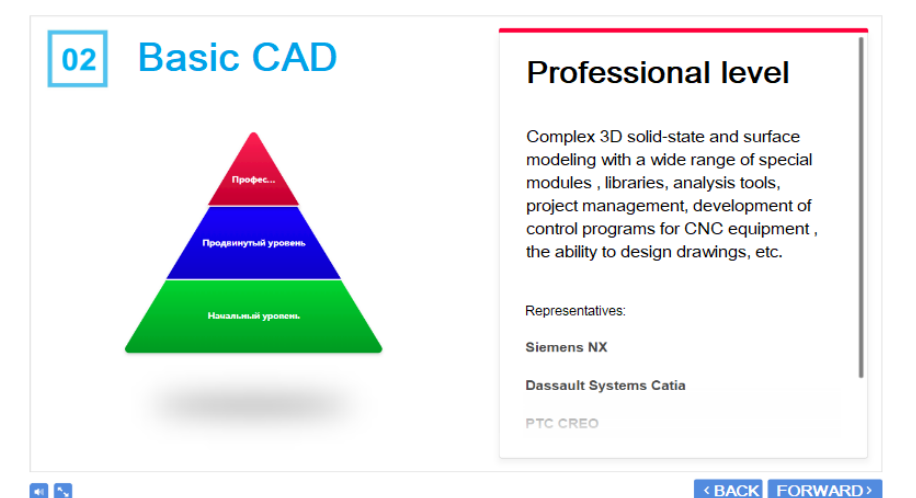
Fig. 6 . Hierarchy of the CAD systems.